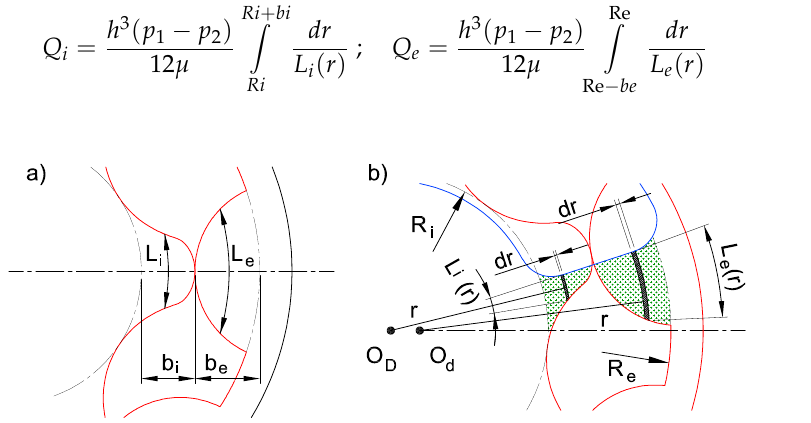
Figure 10. Parameters for the simulation of the leakages on the sides of the gears for a gerotor pump: ( a ) with constant equivalent length; ( b ) with length variable with the radius.